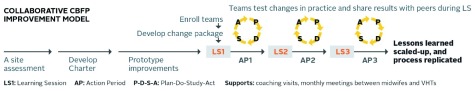
Collaborative Improvement Model.